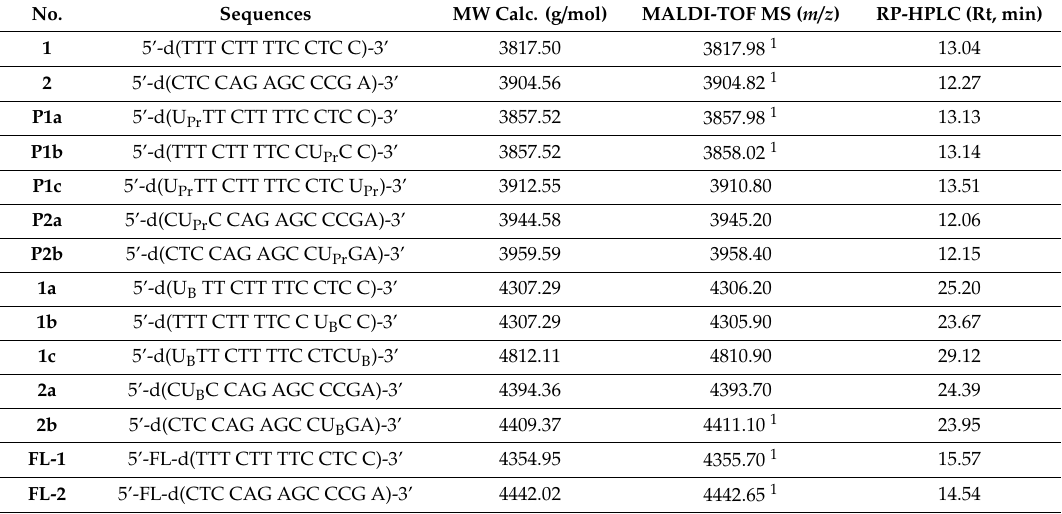
Scheme 2. Labeling of oligonucleotides 1 and 2 with 3-iron-bis(1,2-dicarbollide)ate, a metallacarborane moiety bearing an Fe 3+ cation. Table 1. Sequences, molecular weight, and chromatographic mobility (RP-HPLC) data for the oligonucleotide substrates used in these studies. U Pr and U B represent 2’- O -propargyl uridine and metallacarborane-containing uridine units, respectively.